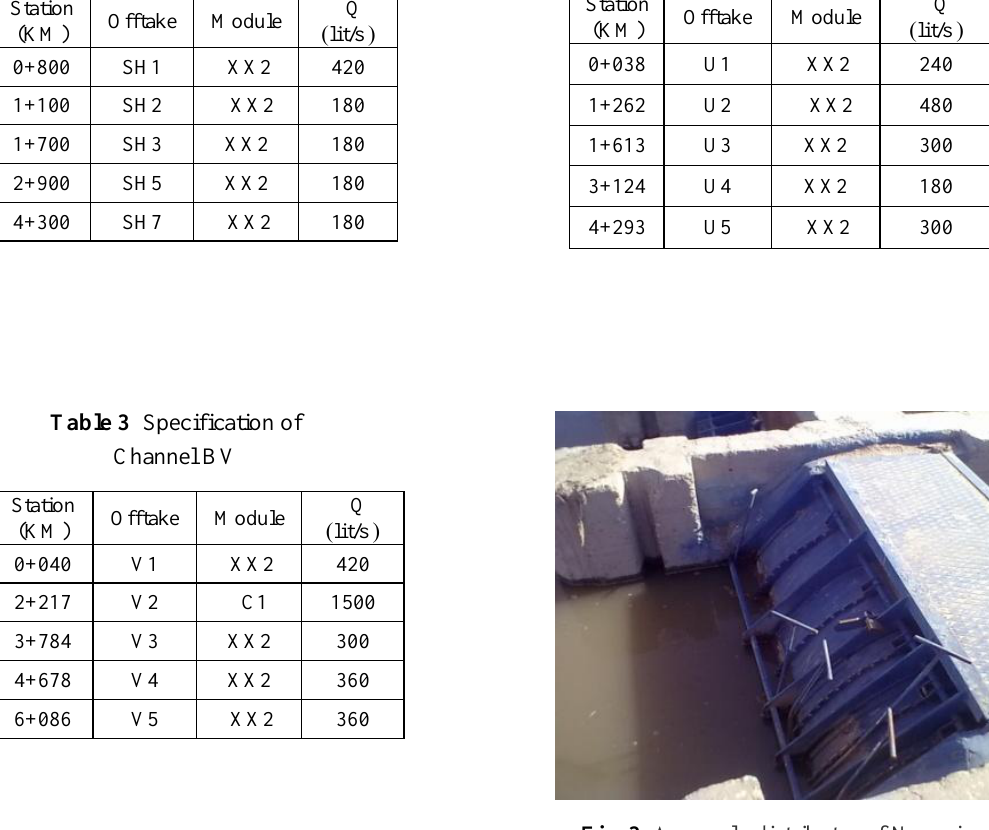
Fig. 3 A sample distributor of Neyrpic orifice Fig 3 . A sample distributor of Neyrpic orifice module in Varamin module in Varamin Network